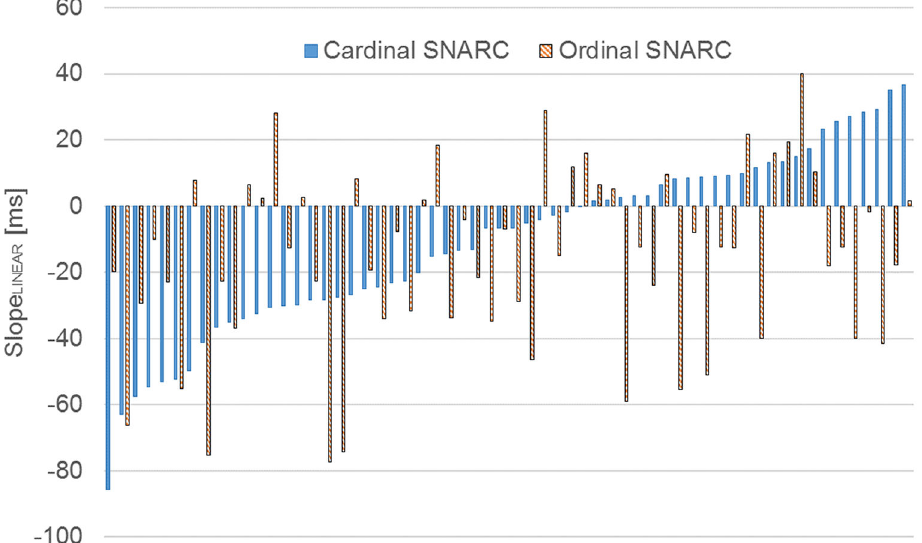
Figure 2. Individual linear regression slope estimates for numerical (cardinal) and weekday sequence (ordinal) stimuli in the comparison task. Participants are sorted by magnitude of the cardinal SNARC and the adjacent striped bar displays the corresponding ordinal SNARC slope. It can be seen that there is no evidence of a systematic relation between ordinal and cardinal